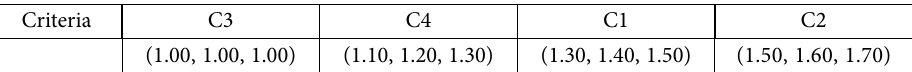
Table 1. Fuzzy assessment of the criteria for classification of products Criteria